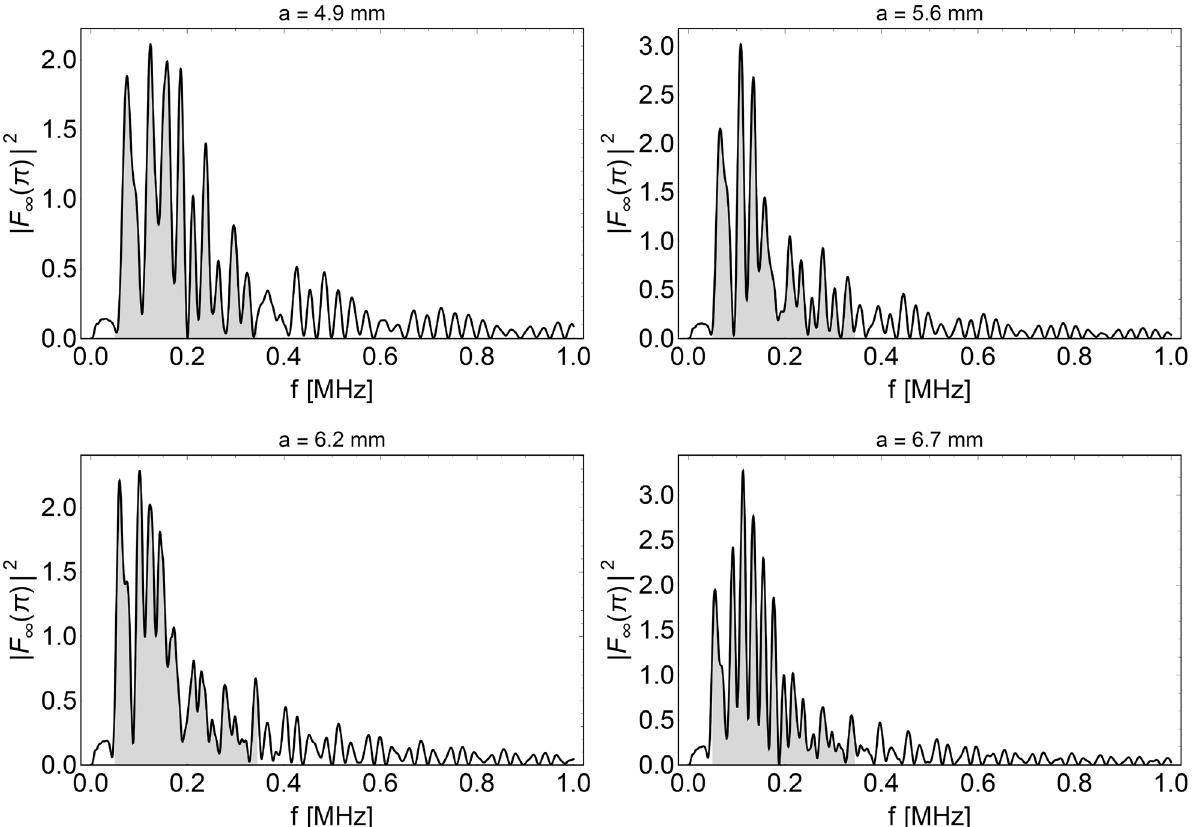
Figure 2. Back scattering form functions obtained from breast tumor moduli reported in Fig. 1 at different sizes, in which the highest scattering band, by considering mode superposition, is